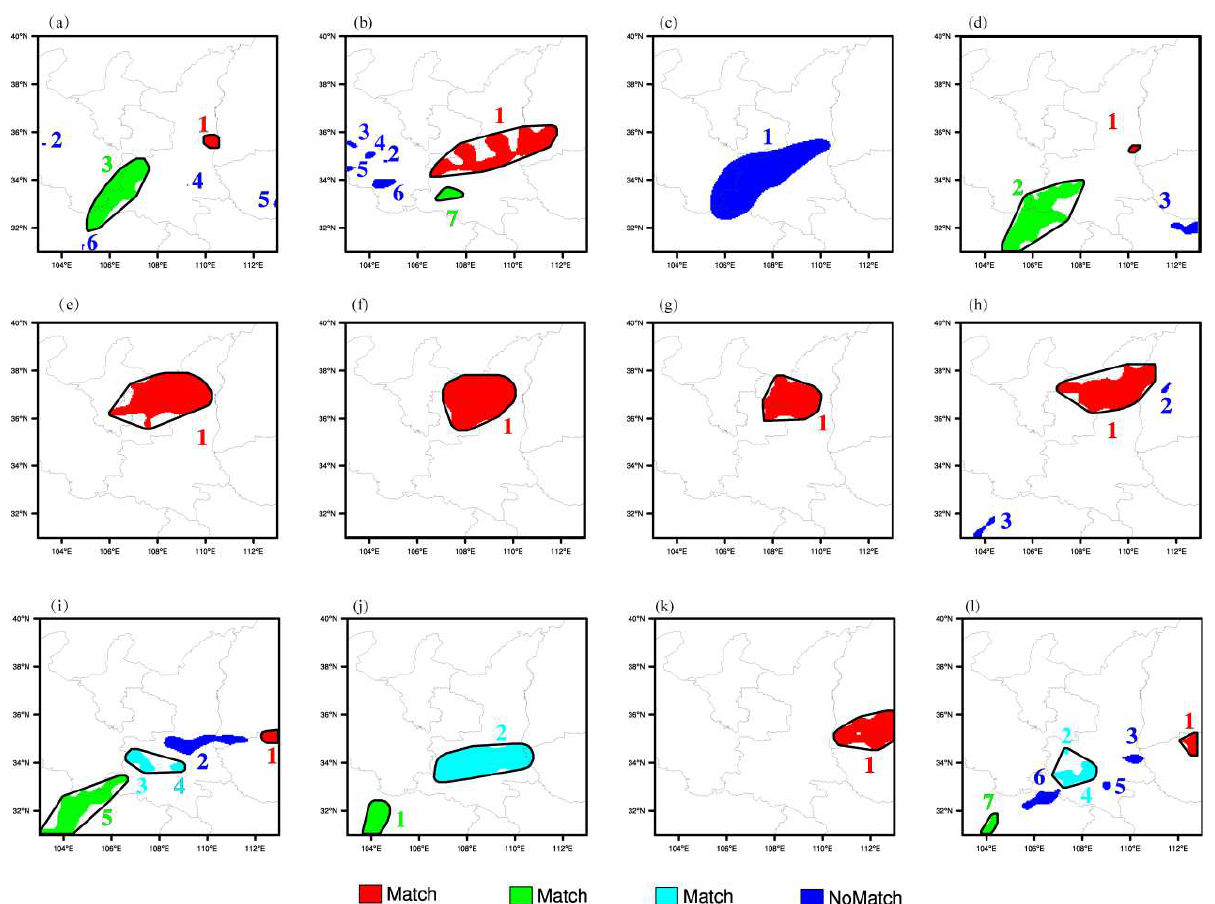
Figure 2. The cases of MODE verification of rainstorm for three precipitation forecast products. ( a – d ) are torrential rain objects identified by ECMWF, CMA-Meso, SCMOC and observed precipitation for case 3, respectively. ( e – h ) are the same as ( a – d ), but for case 5. ( i – l ) are the same as ( a – d ), but for case 7. The red, green and blue in the figure are the matching objects with the same color in the forecast and observation precipitation fields. The blue precipitation object indicates that there is no match between the forecast and observation; that is, according to the matching rule, although there is a precipitation object in the forecast field, there is no precipitation object in the observation field, and vice versa.